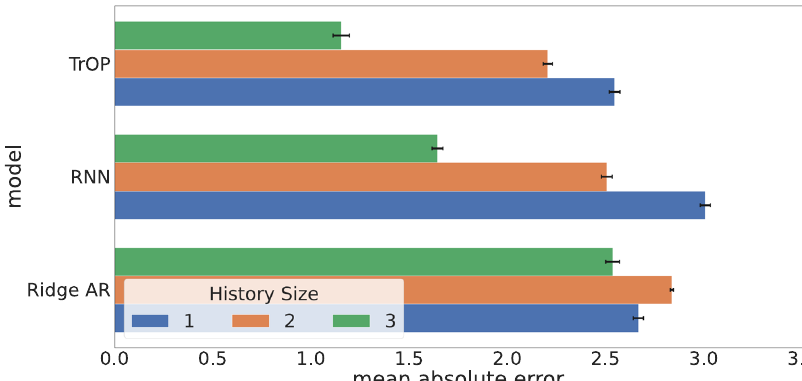
Fig. 2 Model error by available history. Examining the trend in mean absolute error (MAE) rates, with 95% con fi dence intervals, based on available history for multivariate versions of our models. We found that all models perform best with 3 years of data available. For the deep learning approaches, there was a large drop when increasing from 2 to 3 years of history noting the utility in measuring the change in language over time.